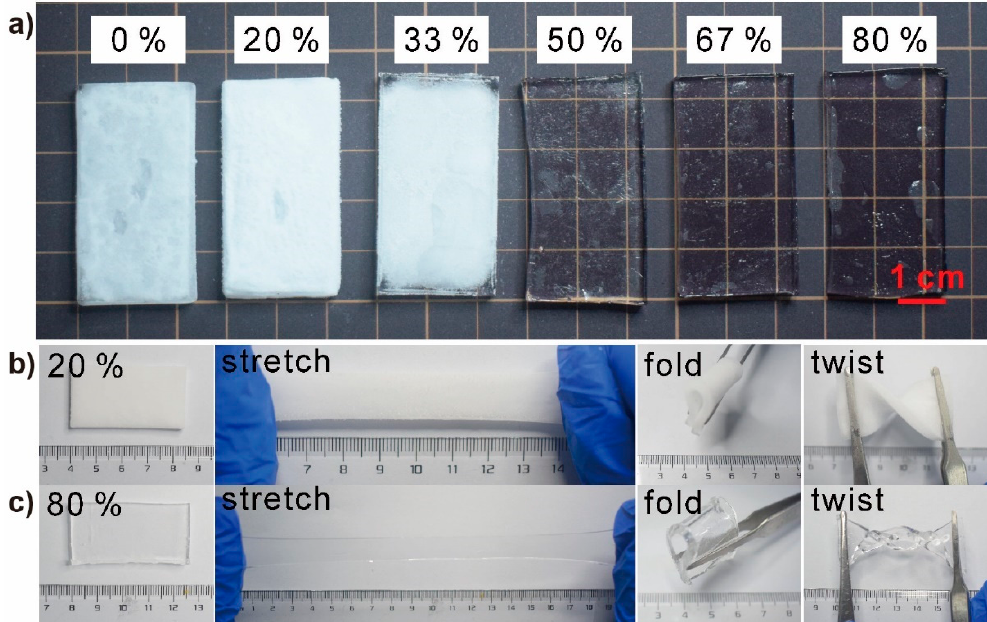
Figure 3. The antifreezing investigation of the PAAm gels. ( a ) Digital photograph of the PAAm hydrogel and PAAm organohydrogels from in-situ gelling after stored at − 40 °C for 24 h. ( b ) The PAAm organohydrogel with 20% glycerol became opaque but maintained mechanical flexibility. ( c ) PAAm organohydrogel with 80% glycerol maintained transparency and mechanical flexibility.